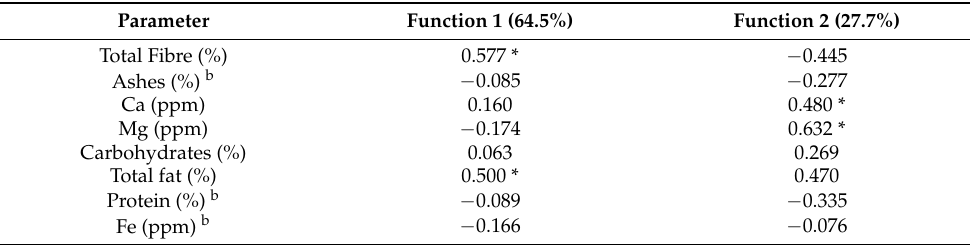
Table 7. Structure matrix resulting from the stepwise discriminant analysis which shows correlations between variables and discriminant factors.